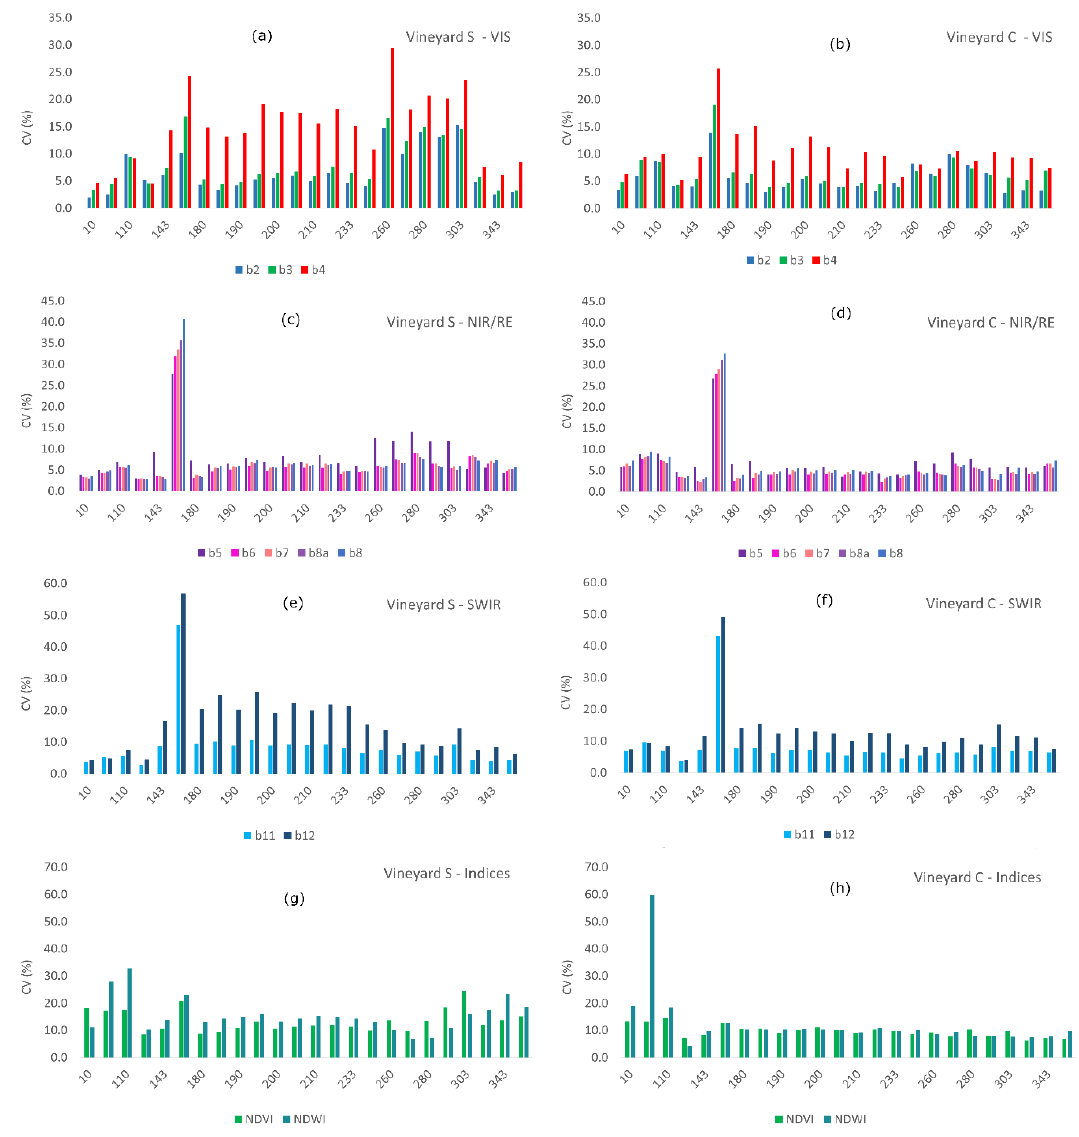
Figure 7. Coefficients of variation (CV) of covered vineyards (S and C) along the year (2016). CV concerns spatial distribution of band/index values within the vineyard. Values were computed at plot level for each date for all the considered S2 bands and for NDVI and NDWI indices. Figures ( a , c , e ) refer to vineyard S and show temporal trends of visible, NIR and SWIR bands, respectively. Similarly, figures ( b , d , f ) refer to vineyard C and show temporal trends of visible, NIR and SWIR bands, respectively. Figure ( g , h ) show temporal trends of spectral indices (NDVI, NDWI) for vineyard S and C respectively. Concerning intra-vineyard spatial distribution of reflectance within S and C covered vineyards (Figure 7), the yearly trends showed that: (a) in the visible range, b4 (red) appeared to express the highest intra-vineyard variability for both S and C (up to 30%). The time pattern was slightly di ff erent in the two vineyards; (b) a reduced, and almost constant, variability a ff ected NIR / red edge bands (5–10%) with a springer exception probably due to time series filtering problems; (c) SWIR bands (b11 and b12) appeared to be highly varying within the vineyards, with a prevalence of b12. Again, S and C showed similar but not equal time pattern; (d) spectral indices (NDVI and NDWI) similarly showed a high intra-vineyard variability with no significant seasonal behavior if not at the beginning and at the end of the